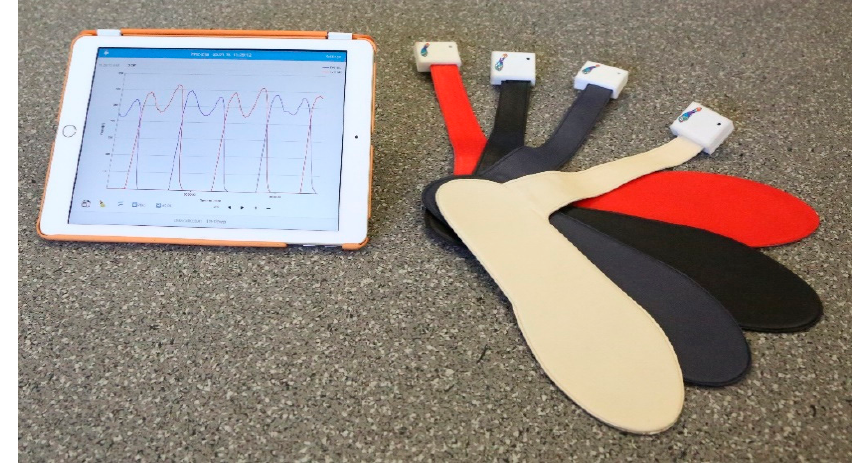
Figure 1. The loadsol ® and a sample data file are pictured here. Photo taken by Michael Diersing.